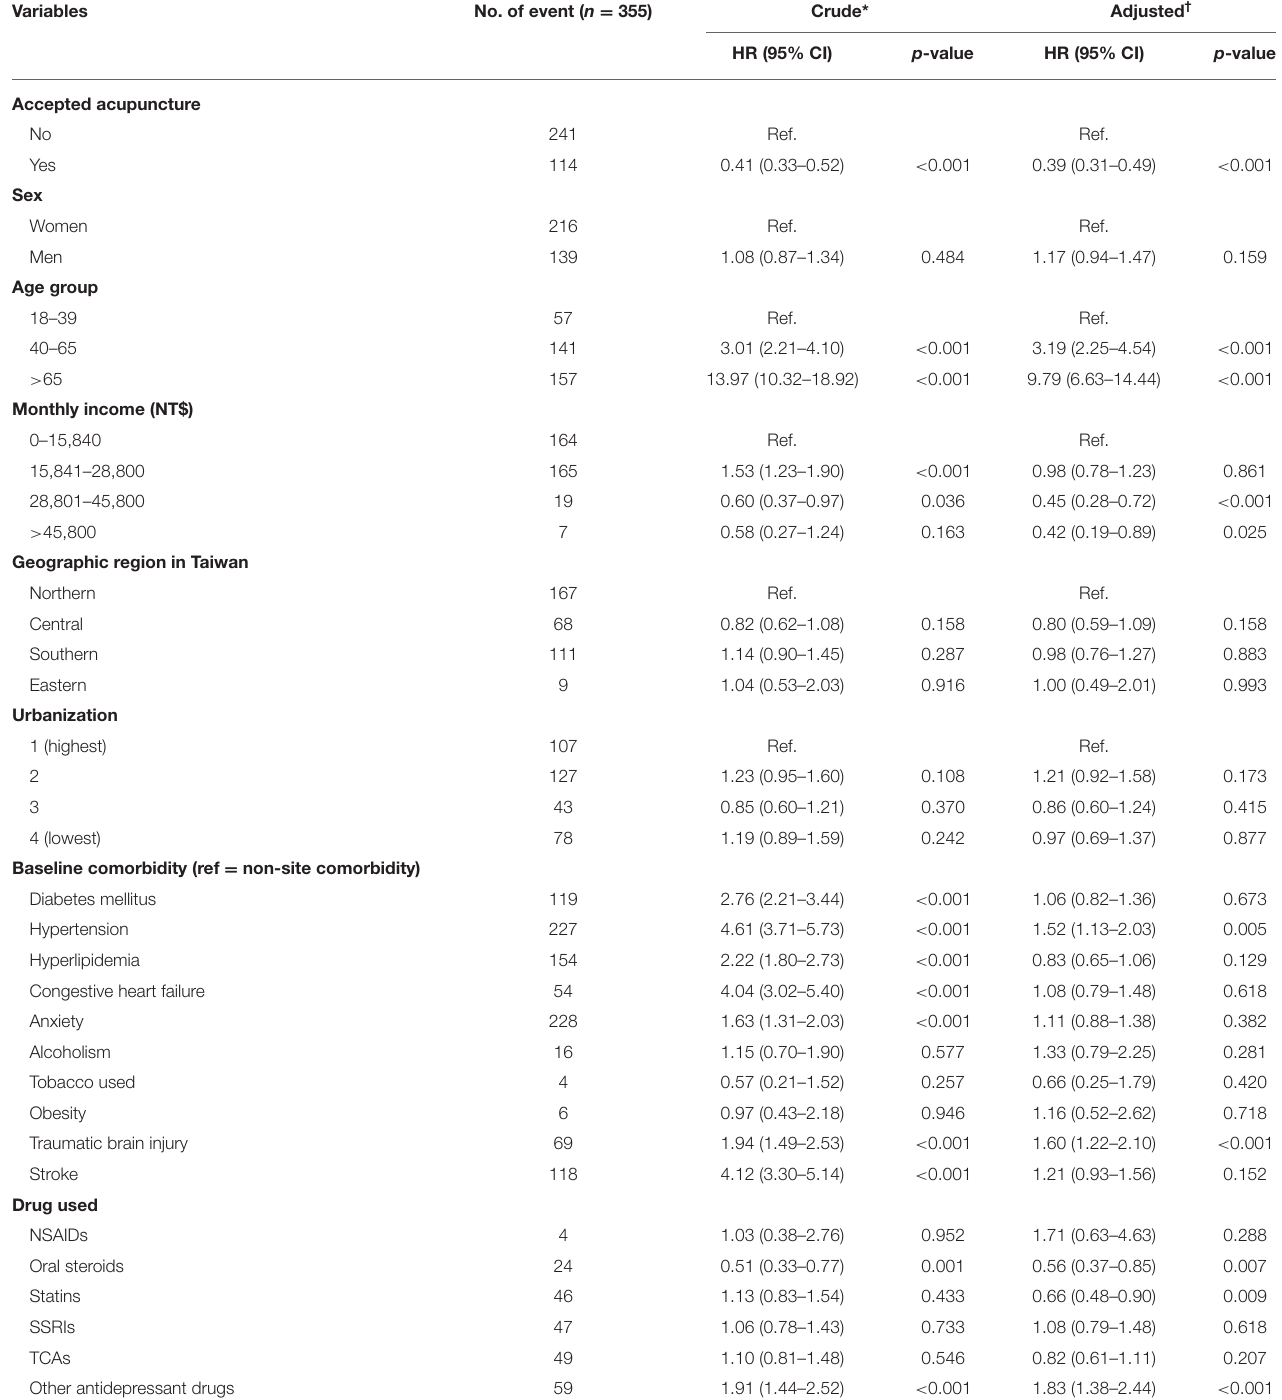
TABLE 3 | Cox proportional hazard models with hazard ratios and 95% confidence intervals of PD associated with acupuncture and covariates among patients with depression.